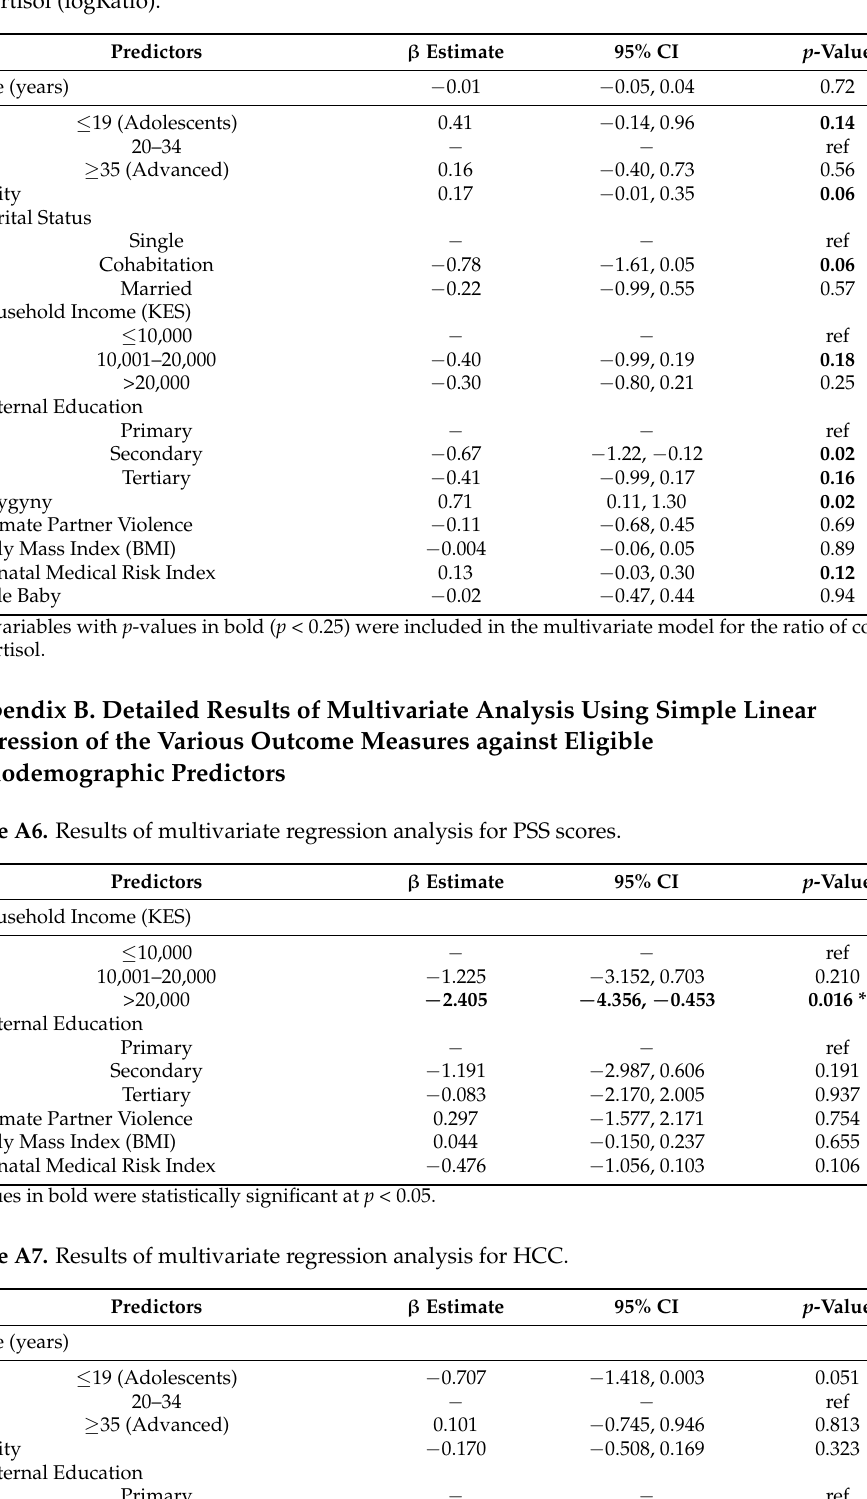
Table A5. Results of bivariate analysis between socio-demographic predictors and ratio of cortisone to cortisol (logRatio).